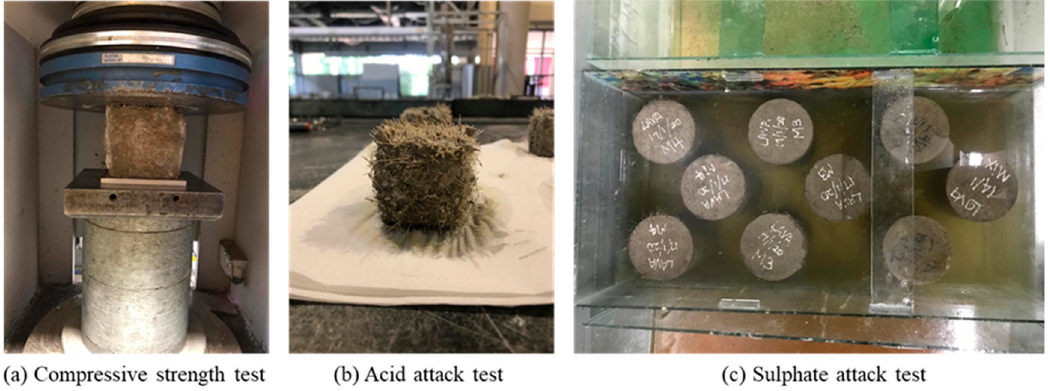
Figure 3. Samples and testing setup: ( a ) Compressive strength test; ( b ) Acid attack test; ( c ) Sulphate attack test